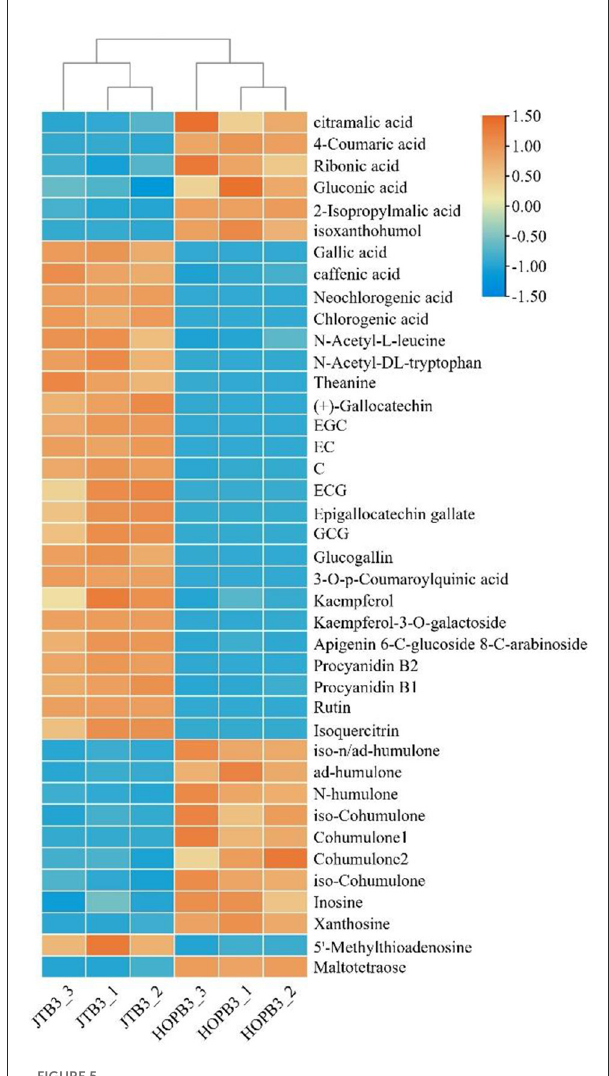
FIGURE5 Heatmap analysis of critical metabolites in two beer samples. A color-coded scale grading from blue to orange corresponds to the content of critical metabolite shifting from low to